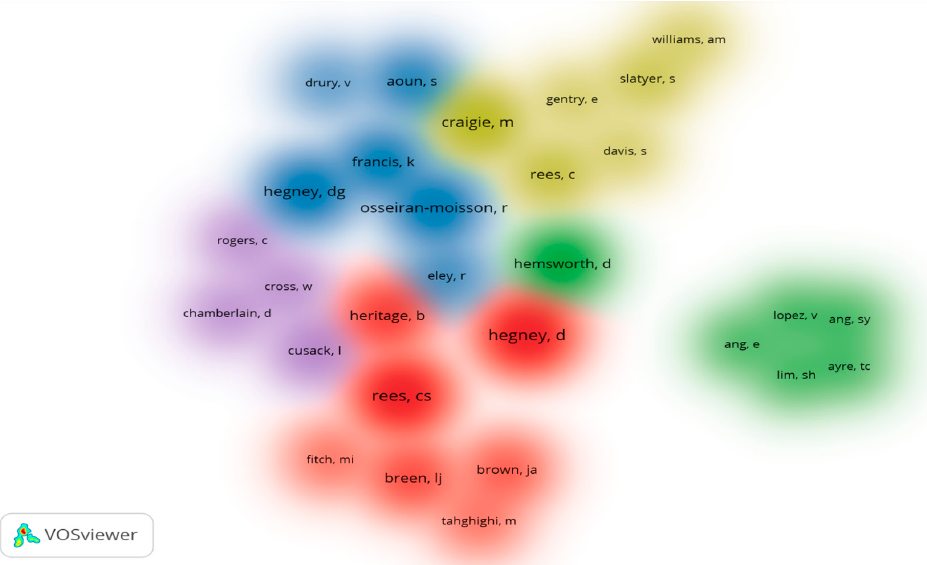
Figure 7. Density of authors’